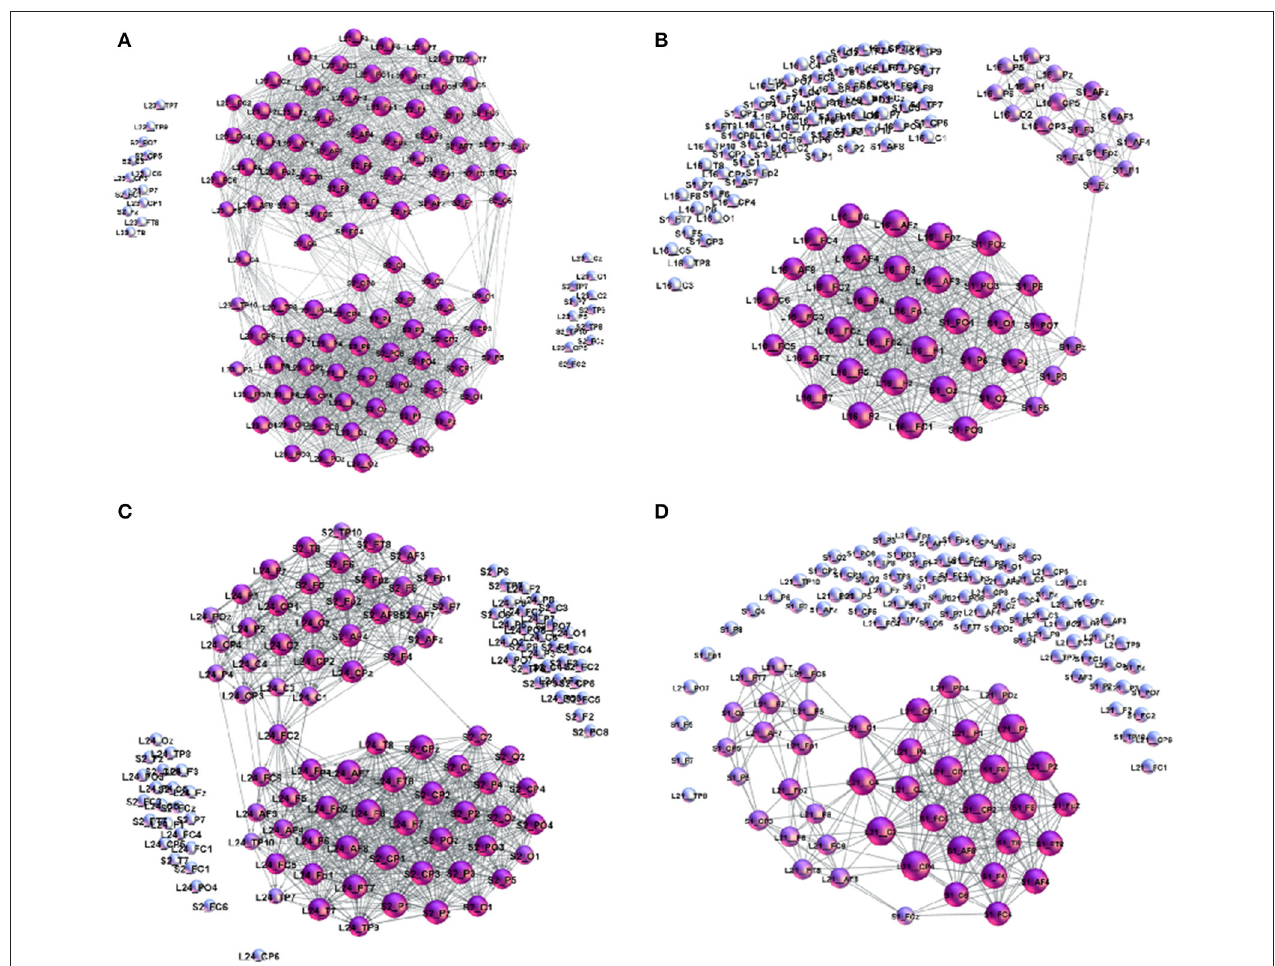
FIGURE 8 | Examples of cross-brain connectivity patterns corresponding to the largest excess topology in Figure 7 : (A) S 2 L 23 –superbrain, (B) S 1 L 16 , (C) S 2 L 24 , and (D) S 1 L 21